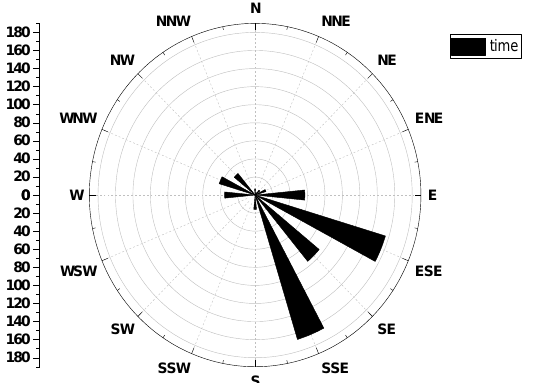
Figure 2. Wind regime of study area (1961 – 2013). ( a ) Monthly and annual wind speed means. 1 – 12 indicate January to December, while 13 gives the annual average. ( b ) Number of gale windy days per year.